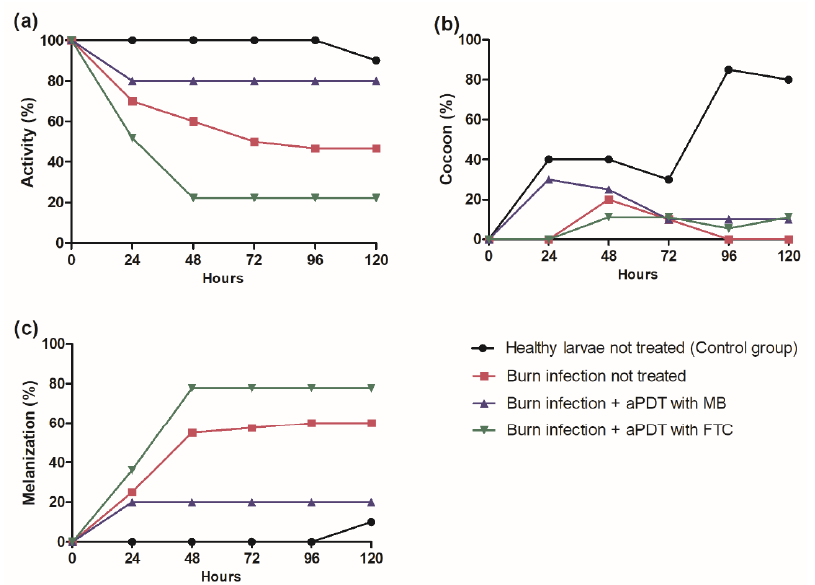
Figure 5. Means of scores obtained in the health index analysis for the groups: healthy larvae not treated (control group), burn infection not treated group, burn infection + aPDT with MB group, and burn infection + aPDT with FTC group. ANOVA and Tukey test ( p ≤ 0.05). ( a ) Movement activity: burn infection not treated group compared to burn infection + aPDT with MB group ( p = 0.2668) and burn infection + aPDT with FTC group ( p = 0.2321). ( b ) Cocoon formation: burn infection not treated group compared to burn infection + aPDT with MB group ( p = 0.8055) and burn infection + aPDT with FTC group ( p = 0.9989). ( c ) Melanization: burn infection not treated group compared to burn infection + aPDT with MB group ( p = 0.1713) and burn infection + aPDT with FTC group ( p = 0.6183).